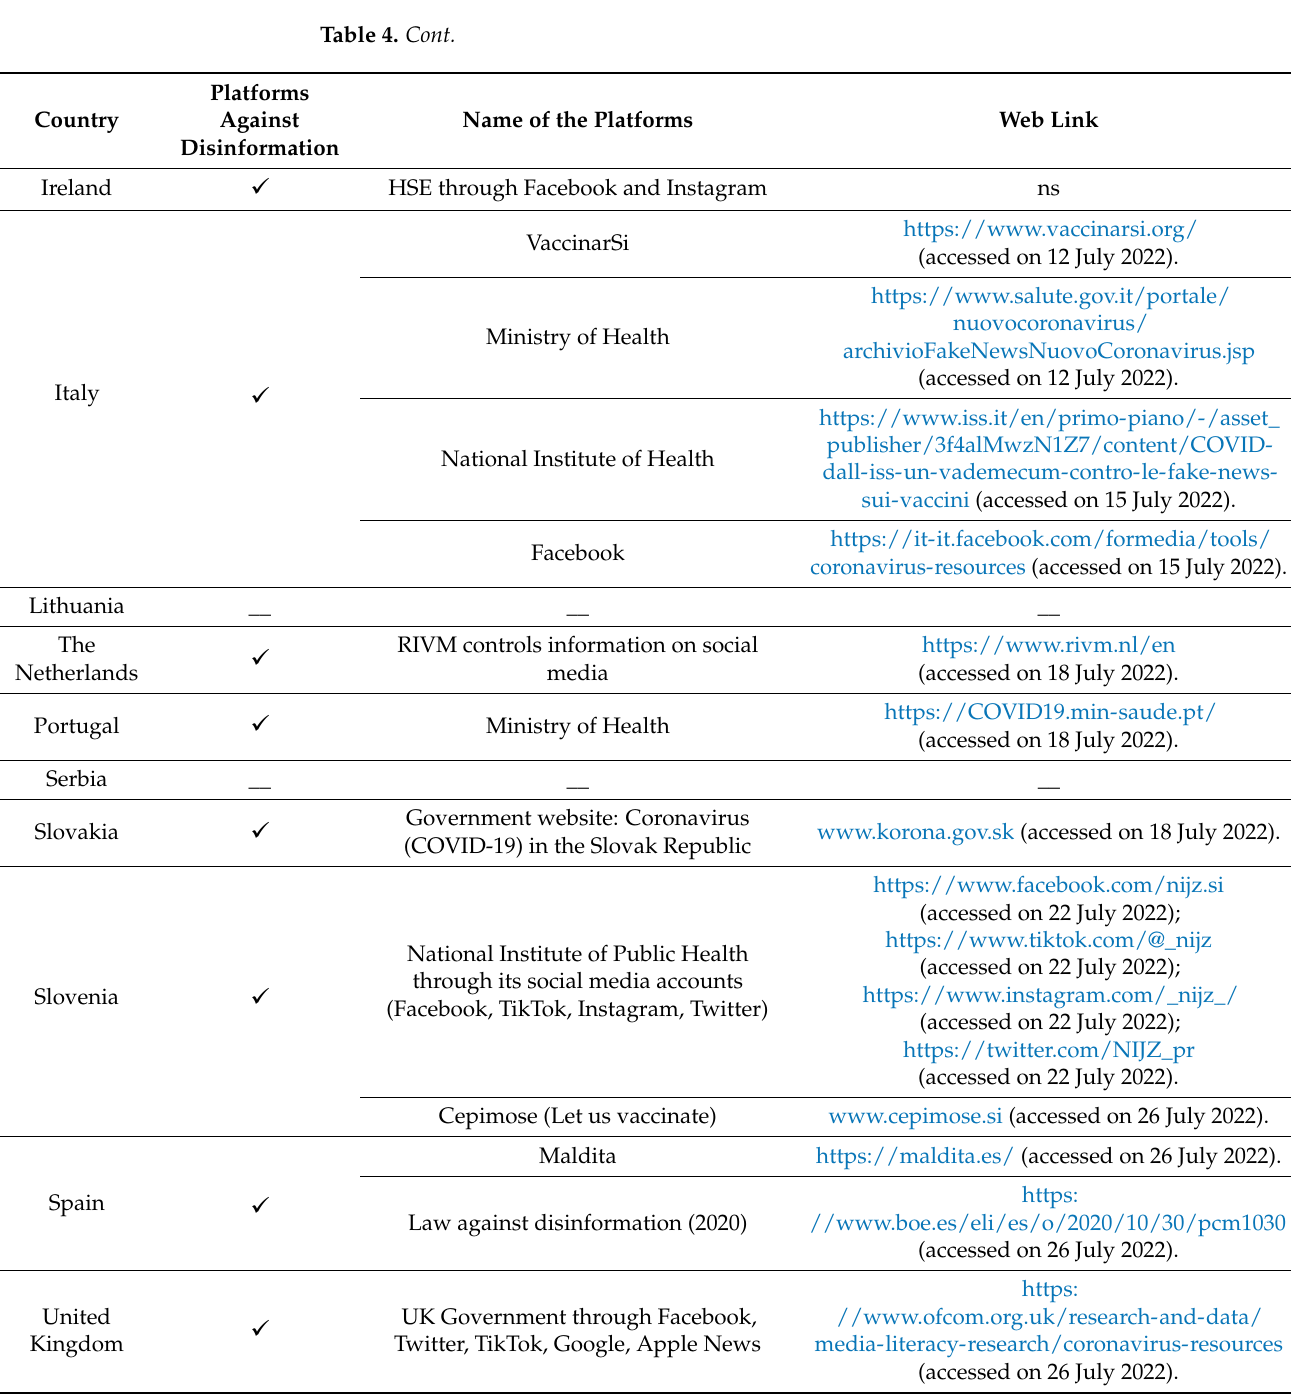
Table 4. Online platforms fighting COVID-19 related disinformation.